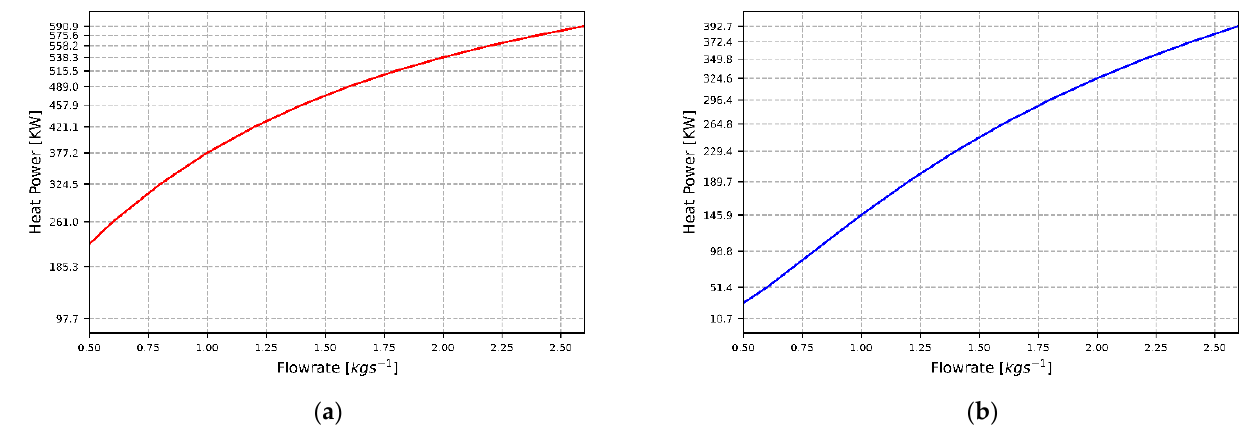
Figure 9. Heat Power as the flow rate value changes: ( a ) Coaxial WBHE; ( b ) U-tube WBHE.